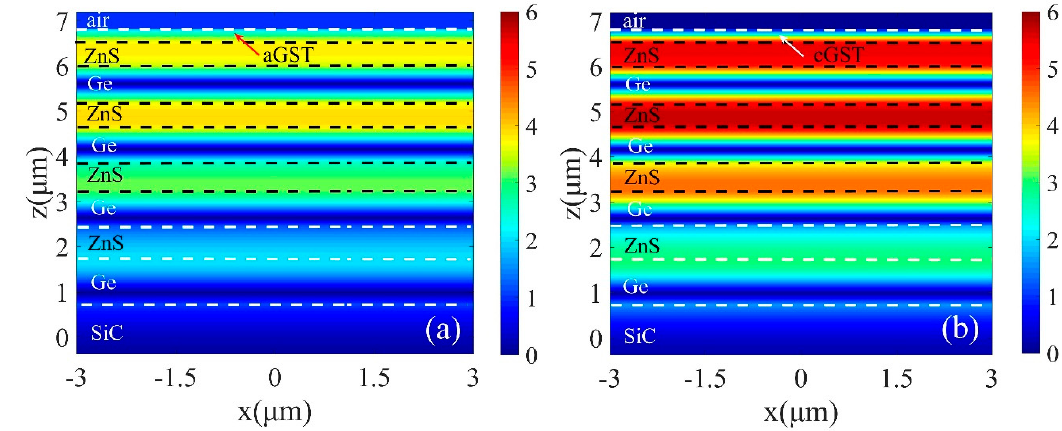
Figure 3. Electric field distribution profiles at the resonance wavelength of 11.34 µ m in x - z plane with ( a ) amorphous (aGST) and ( b ) crystalline (cGST) stable structural phases, respectively.